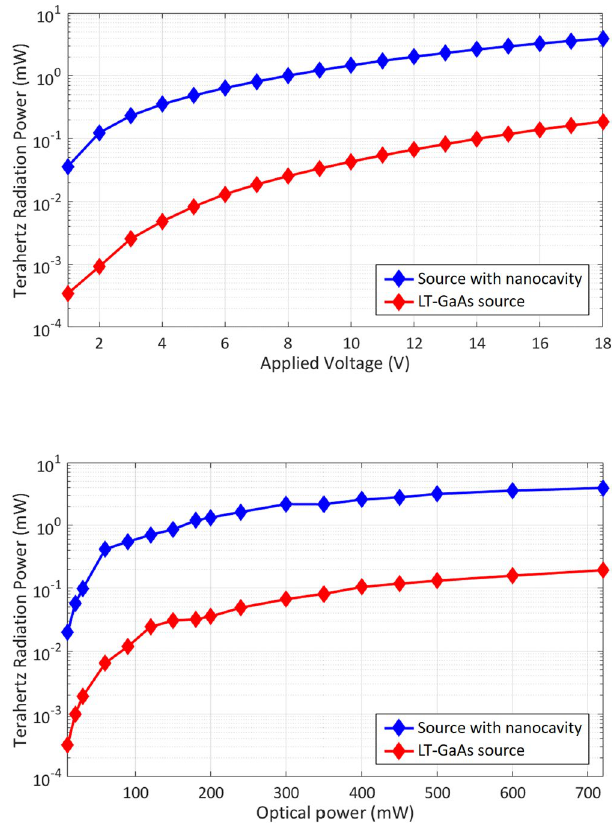
Figure 6. ( a ) Radiated terahertz power levels of the nanocavity-based terahertz source and the terahertz source fabricated on the LT-GaAs substrate as a function of the bias voltage under an optical pump power of 720 mW. ( b ) Radiated terahertz power levels of the nanocavity-based terahertz source and the terahertz source fabricated on the LT-GaAs substrate as a function of the optical pump power under a bias voltage of 18